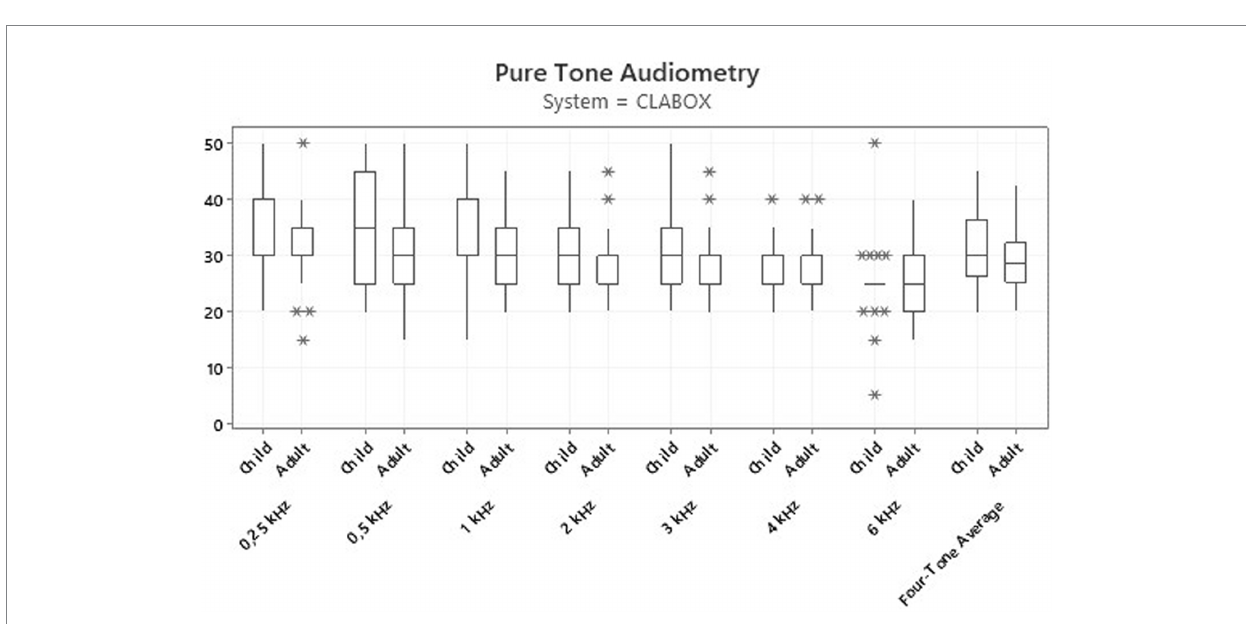
FIGURE 2 HINT with fixed noise (S/N + 10 dB) and adaptive noise at 55 dB with the CLABOX. The box plot represents the 25th and 75th percentiles (box boundaries) and the medians (horizontal line). Outliers are indicated with